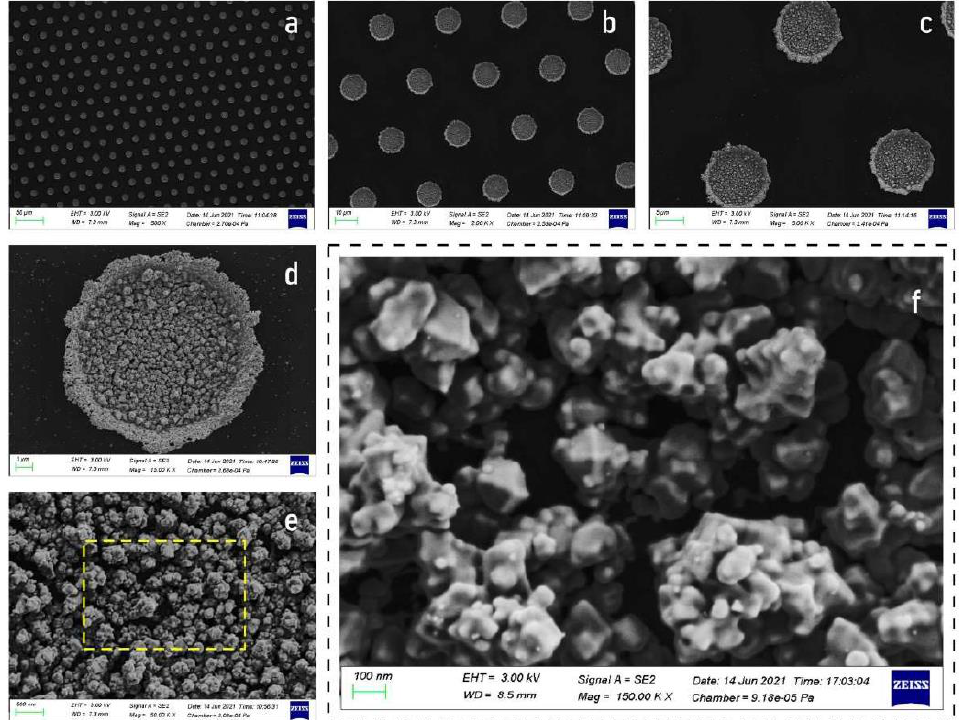
Figure 3. SEM images of gold nanoparticles clusters taken at low magnification reveal the fabrication process capability to attain maximum control over the shape and the size of the clusters ( a – c ). SEM micrographs of the samples taken at higher magnification ( d – f ) illustrate the particle morphology at the nanoscale.